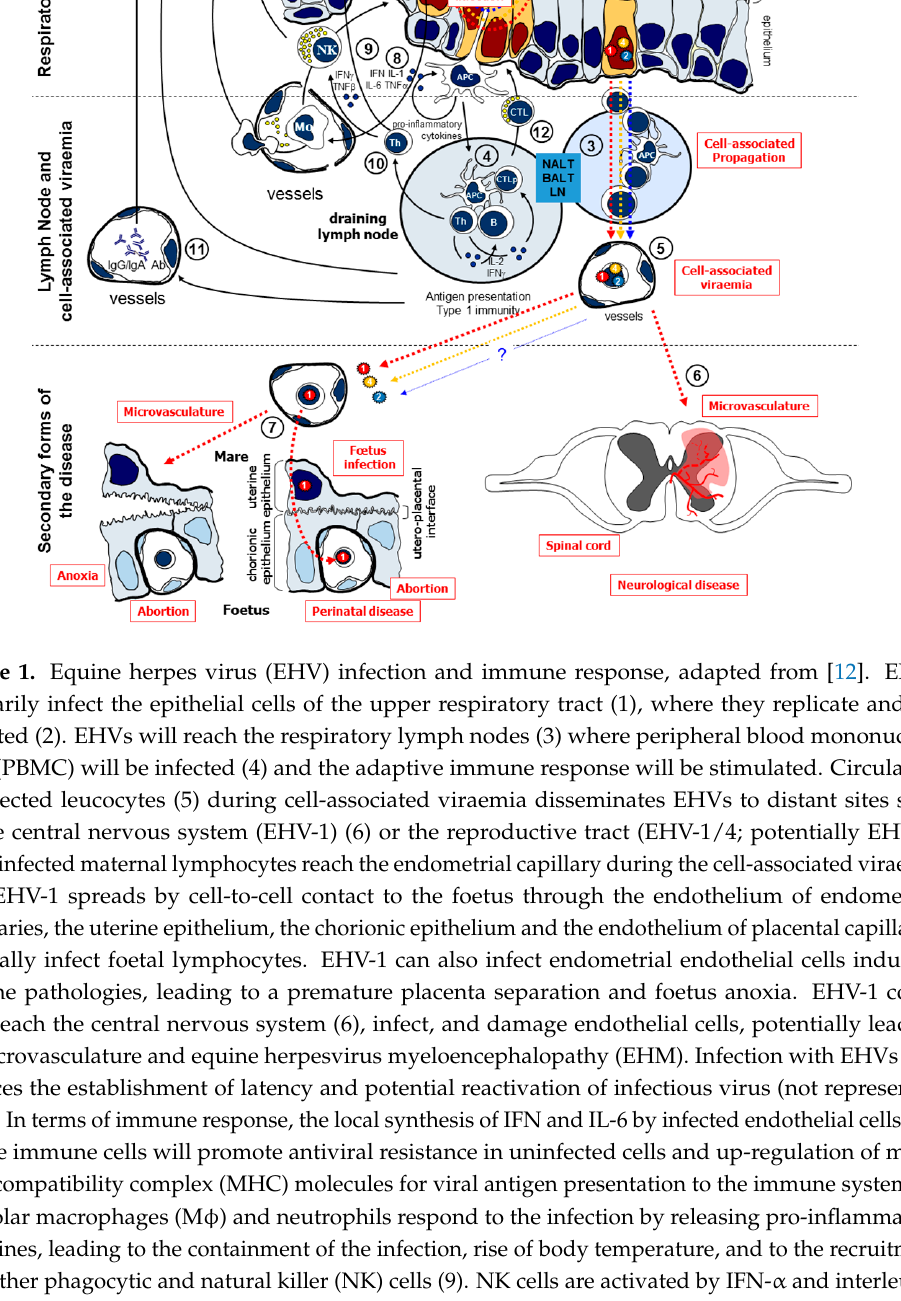
nasal-associated lymphoid tissue.